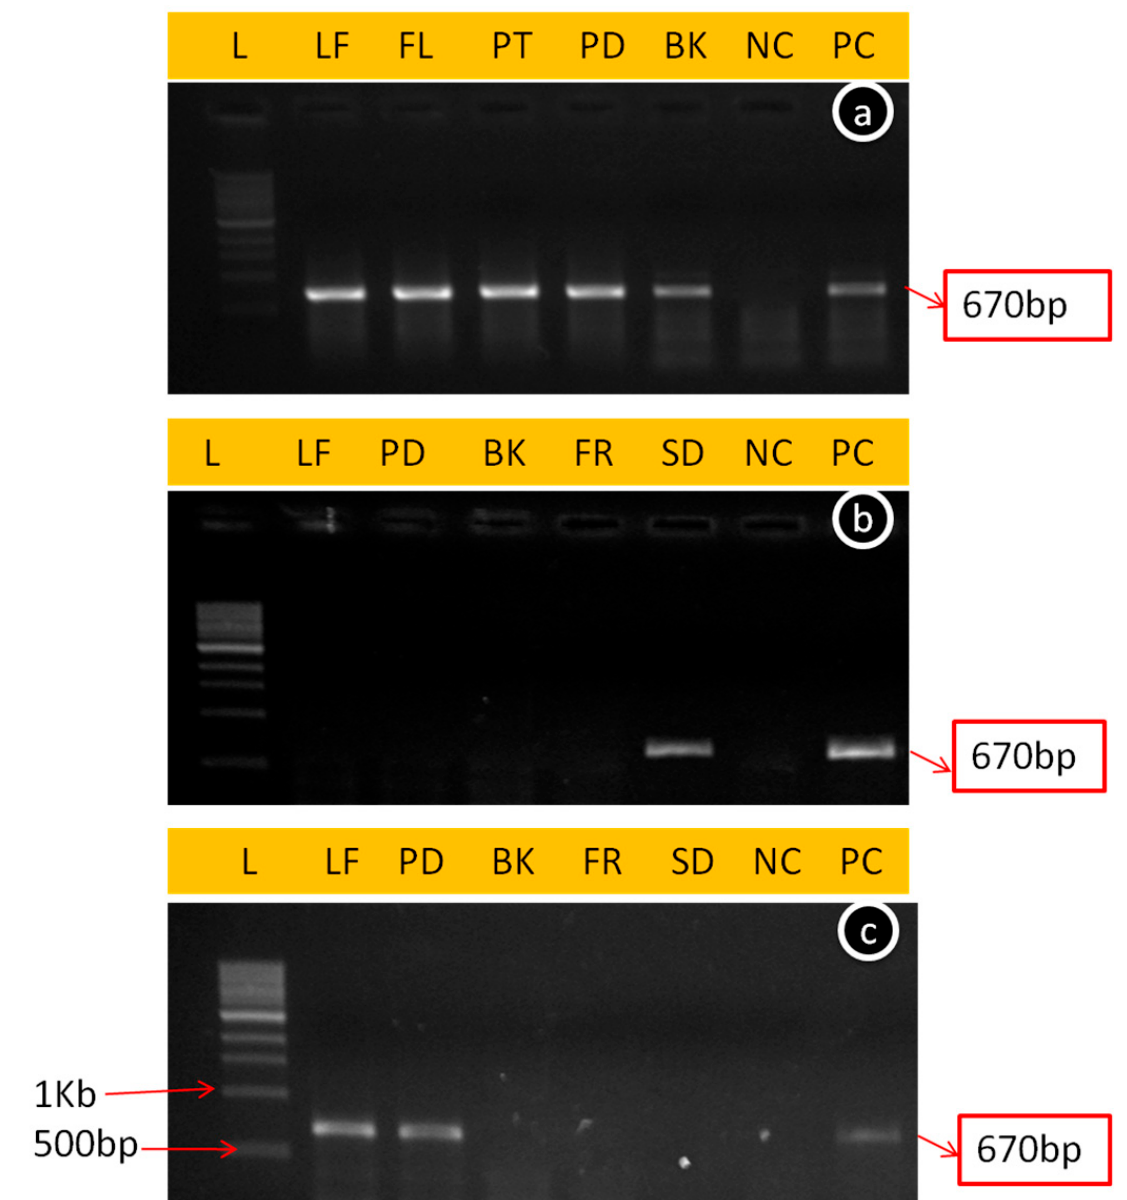
Figure 4. Amplicon of 670 bp amplified from ApNMV-infected tissues of cultivar Golden Delicious (GD) plant tissues by conventional RT-PCR during the spring season ( a ), summer season ( b ) and autumn season ( c ), where L: ladder 1 kb, LF: Leaf, FL: Flowers, GD4:Bark, PT: Petals, PD: Pedicel, BK: Bark, FR: Fruit, SD: Seed, NC: Negative control, and PC: Positive control .